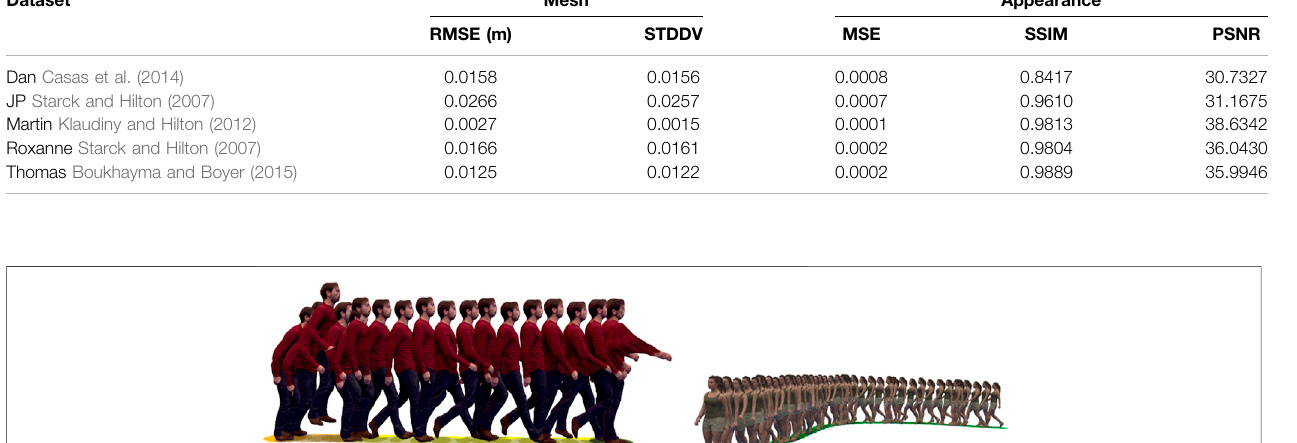
Table 2 . Examples of character animation using Deep4D motion graphs are shown in Figures 9 , 6 . Results demonstrate that the proposed generative representation allows interactive character animation with seamless transitions between sequences based on interpolation of the latent space. The meshes are coloured to illustrate different motion sequences and interpolation between them when performing a blend transition. The learned generative model for shape and appearance synthesises animation with a quality similar to the input 4D video.